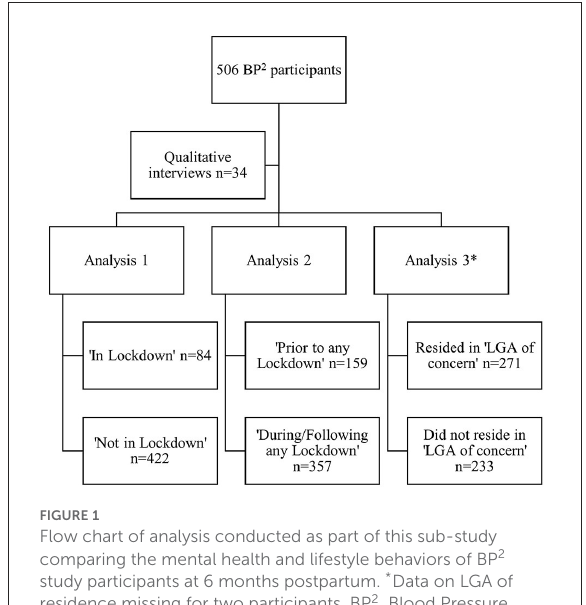
FIGURE1 Flow chart of analysis conducted as part of this sub-study comparing the mental health and lifestyle behaviors of BP 2 study participants at 6 months postpartum. * Data on LGA of residence missing for two participants. BP 2 , Blood